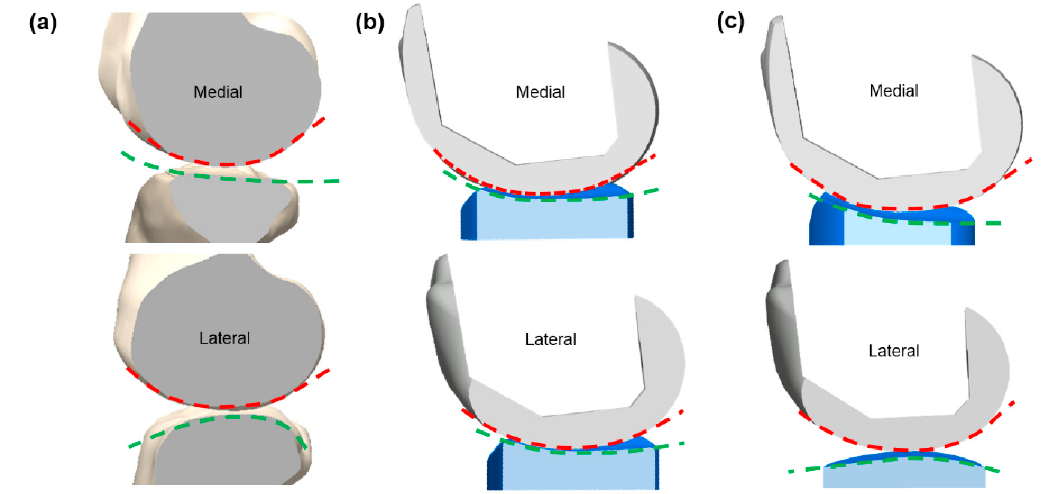
Figure 3. Comparison of tibiofemoral conformity of ( a ) normal knee; ( b ) femoral component derived from customized TKA and tibial insert derived from femoral component; ( c ) fully anatomy-mimetic customized TKA.